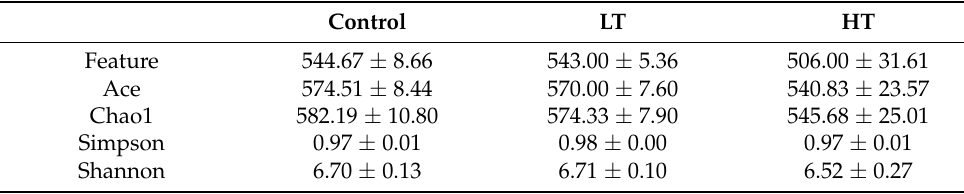
Table 5. Effect of TA on the colonic microbial α -diversity of Brandt’s